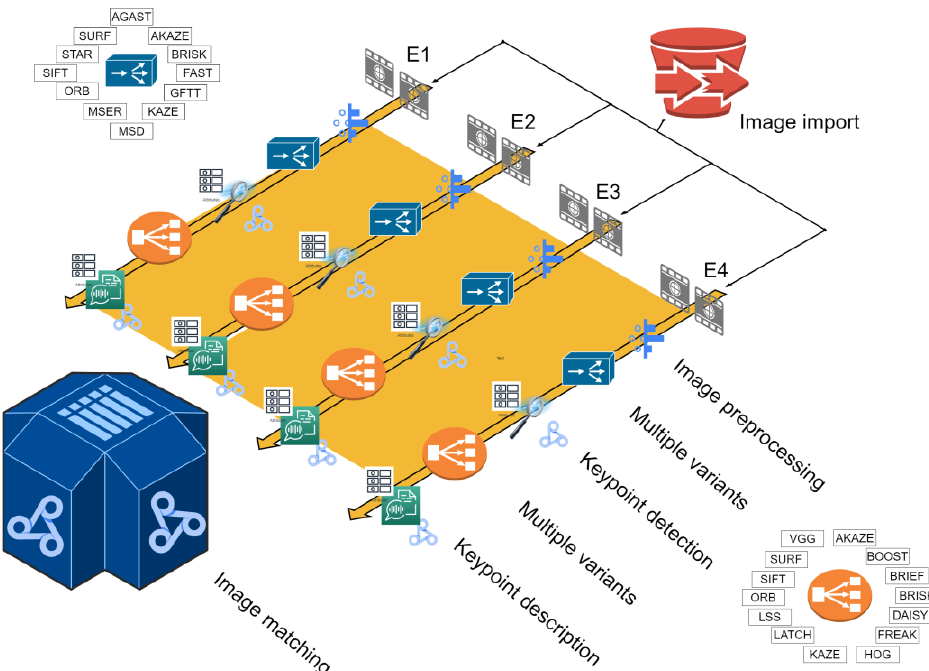
Figure 14. Image matching evaluation workflow.